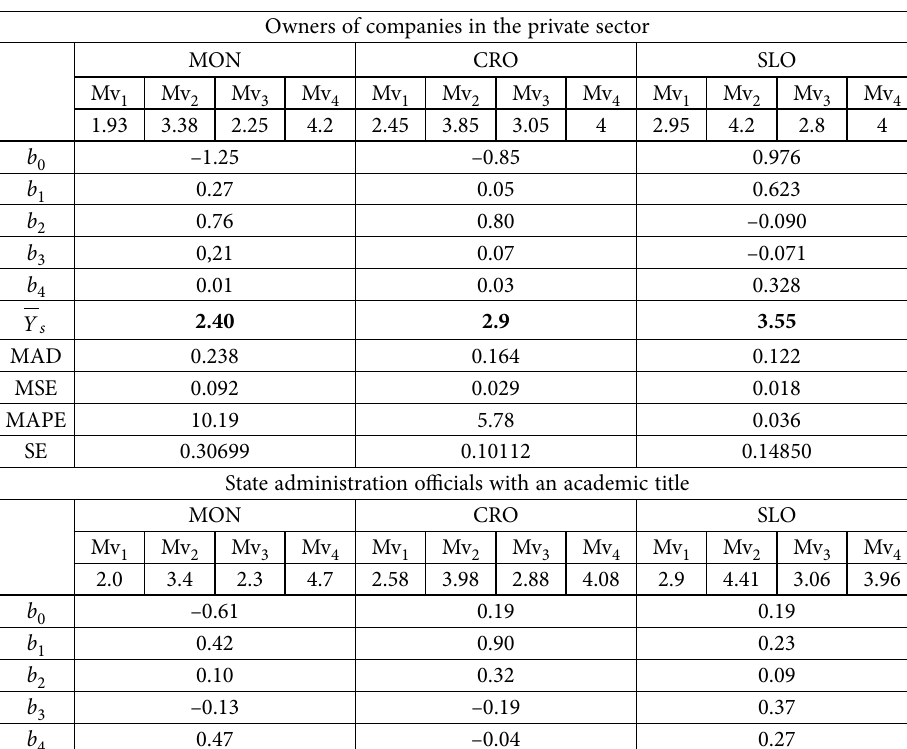
Table 5. Mean values of the dependent variable s Y in the case of MON, CRO, SLO different categories of respondents (source: calculated by